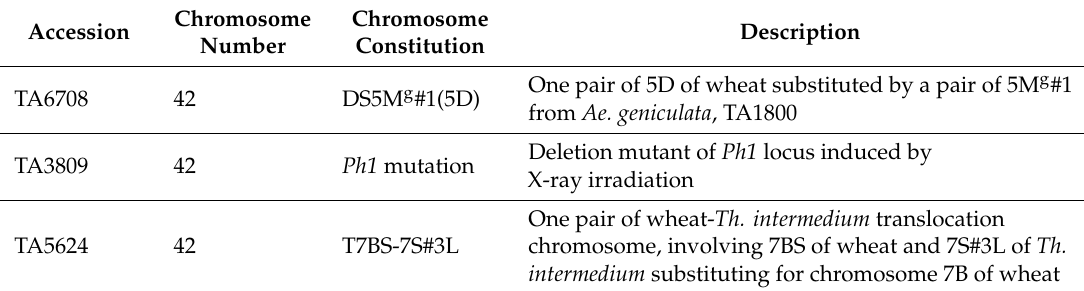
Table 1. Cytogenetic stocks used for studying homoeologous recombination in